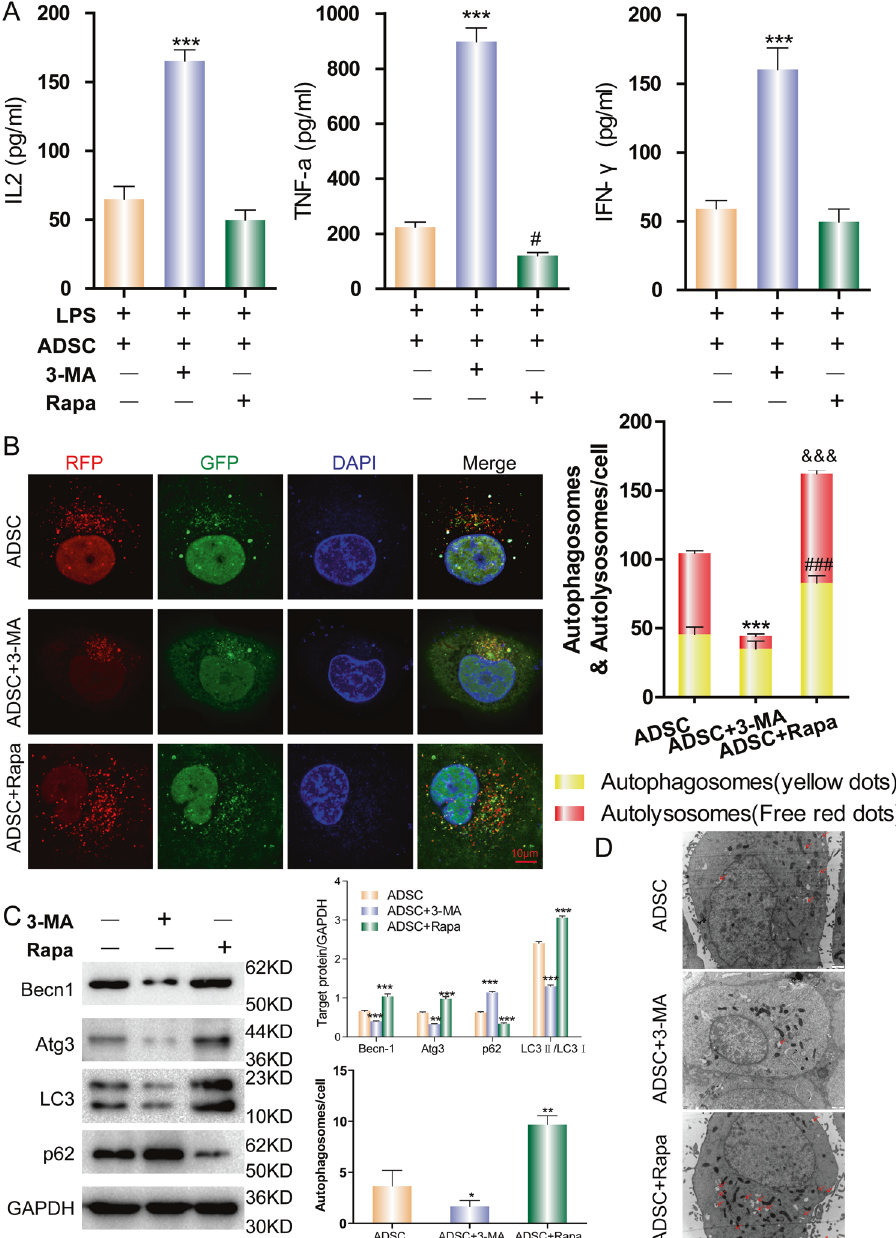
Fig. 5 The underlying mechanism of autophagy regulation in ADSC. ADSCs were cultured in vitro and treated with a type III PI3K inhibitor 3-mA or mTOR inhibitor (rapamycin). MLE-12 cells were cocultured with treated ADSCs via a Transwell system and stimulated with LPS. A The level of in fl ammatory cytokines IL-2, TNF- α , and IFN- γ in the supernatants of MLE-12 cells cultured with different groups of ADSCs were detected by ELISA. *** P < 0.001. B Autophagy in the different groups of ADSCs was detected using an mRFP-GFP-LC3 dual- fl uorescence autophagy indicator system under a confocal microscope. *** P < 0.001; ### P < 0.001; $$$ P < 0.001. C The levels of autophagy-related protein indicators were detected by WB. *** P < 0.001. D Autophagosomes were detected by electron microscopy. Red arrows indicate the autophagosomes. The experiment was repeated triple. Data are shown as means± SD, * P < 0.05, ** P < 0.01. (determined by unpaired t test or one-way ANOVA with Tukey